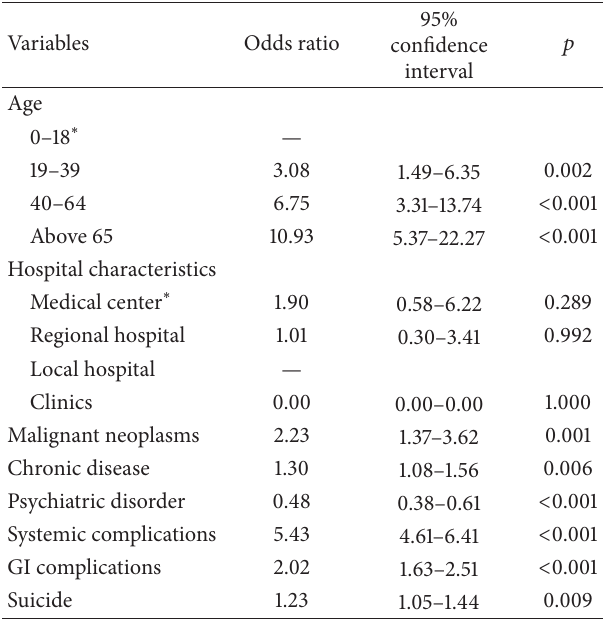
Table 4: Multivariate model of risk factor associated with in- hospital mortality in patients with corrosive